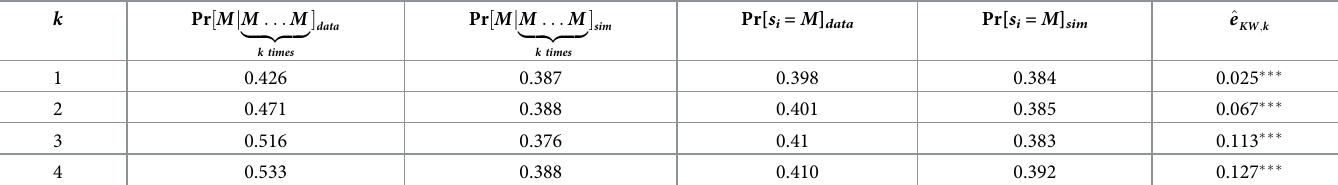
Table 1. Kemba Walker shows significant levels of streakiness, even after adjusting for errors in the shot make probability